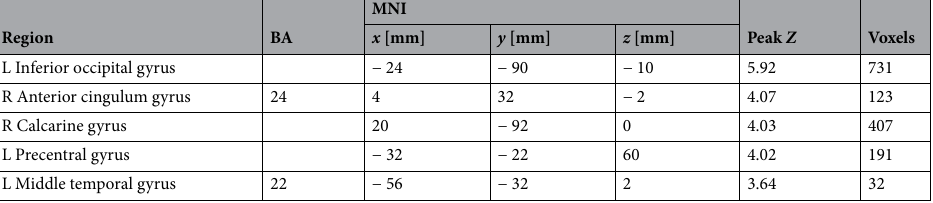
Table 4. MNI coordinates of the activated clusters in trial 4. In this trial, a stimulation current amplitude that was 0 times that of the standard amplitude was applied. Threshold values of uncorrected p and cluster extent k were set as smaller than 0.001 and more than 20, respectively. L left hemisphere; R right